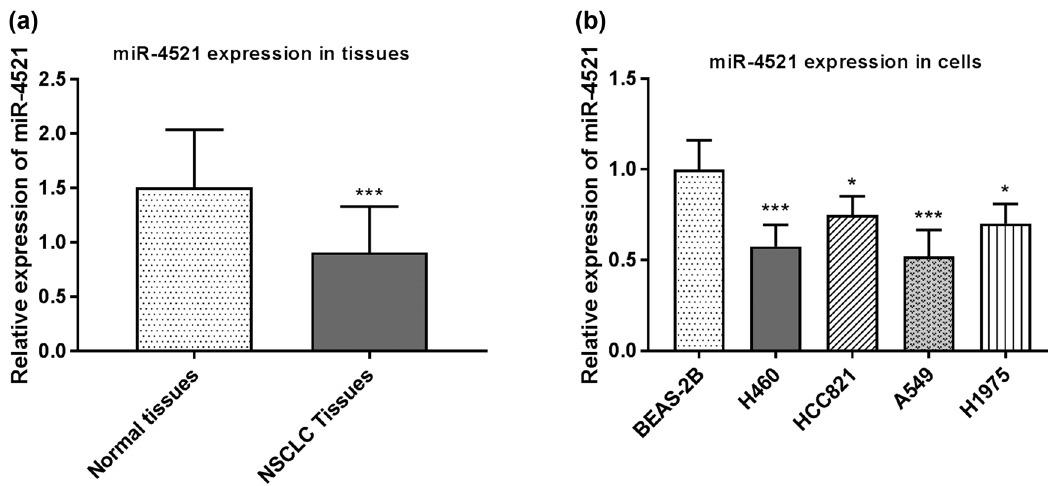
Figure 1: The relative expression of miR - 4521 in NSCLC tissues and cells. ( a ) Compared with adjacent noncancerous lung tissues, the expression of miR - 4521 in NSCLC tissues was signi fi cantly downregulated ( *** P < 0.001 ) . ( b ) Compared with the lung epithelial cell BEAS - 2B, the expression of miR - 4521 in the NSCLC cell lines ( H460, HCC821, A549, H1975 ) was signi fi cantly downregulated ( * P < 0.05, *** P < 0.001 )